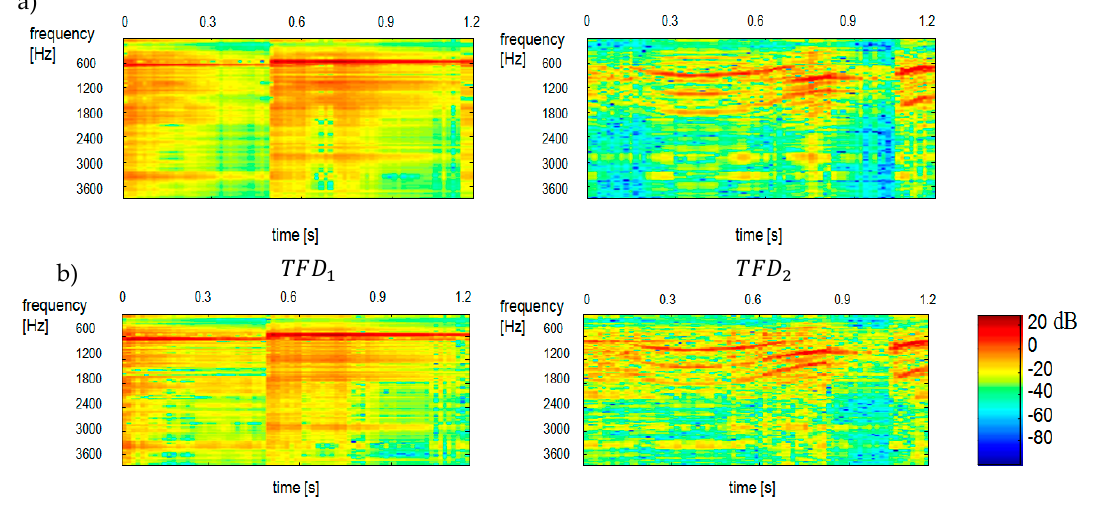
Figure 9. Reconstructed spectrograms (spectra) of TFD 1 and TFD 2 components obtained by k-mean partitional clustering and the β distance of Gaussian distribution. TFD 1 —ringer, TFD 2 —baby. The results were obtained for the variances ( a ) α = 0.7 and ( b ) α = 0.8, respectively, and the signal duration of 1.2 s.